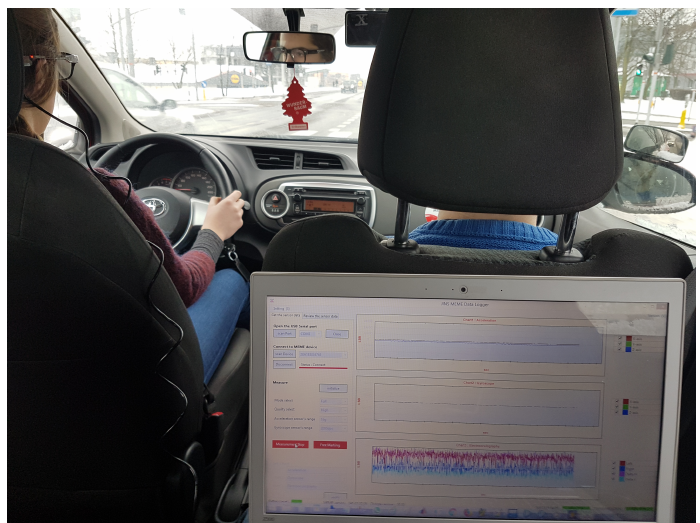
Figure 1. Experiment set-up.